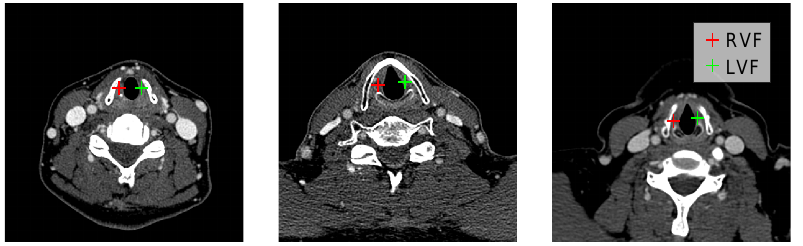
Figure 1. Right and left vocal folds (RVF and LVF) shown in axial slices of three neck CT volumes.